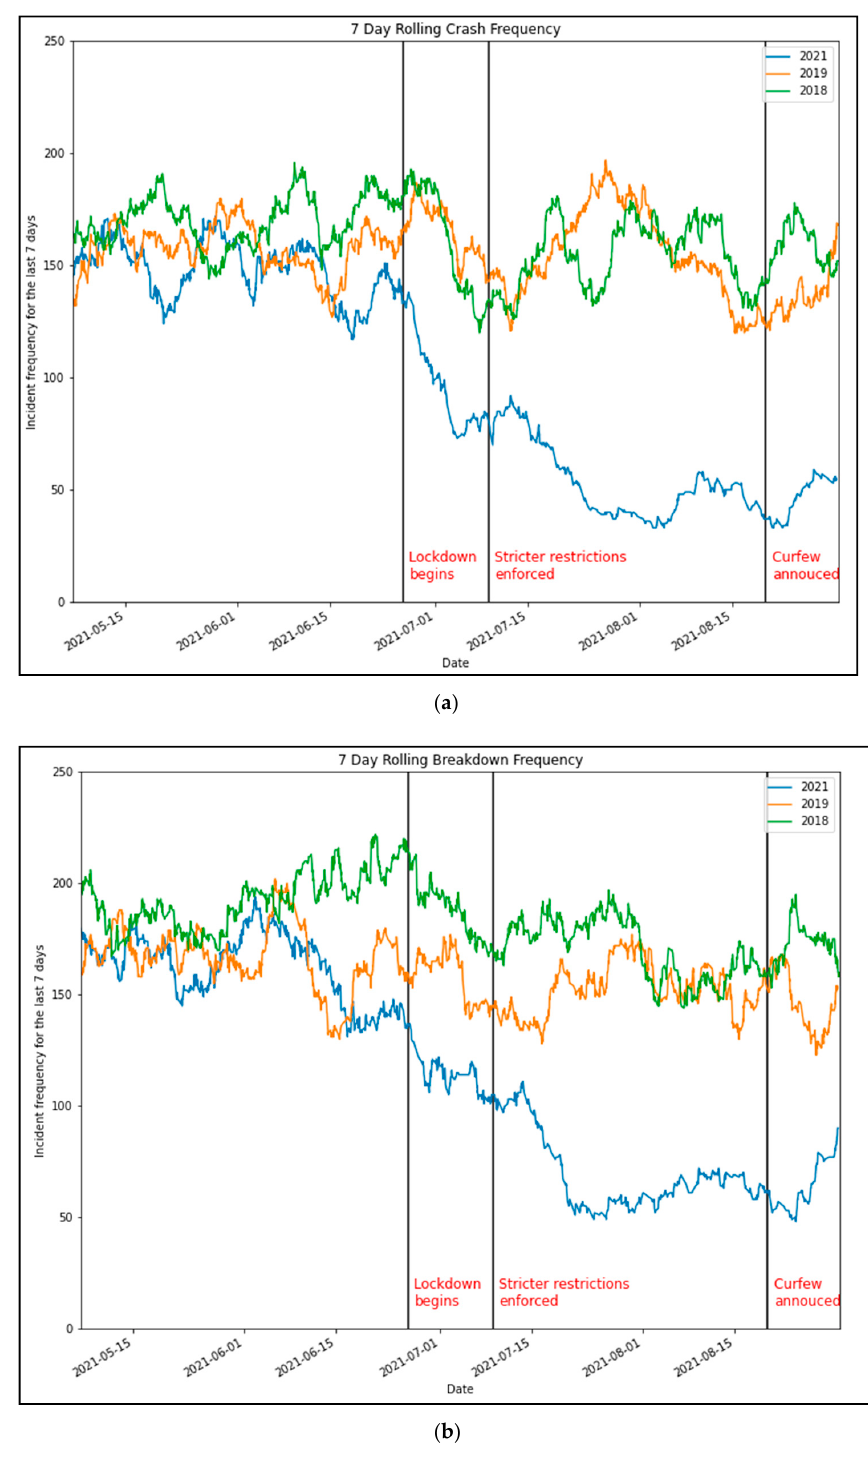
Figure 5. Comparison of seven-day rolling traffic incident frequency (2021 vs 2018 and 2019). ( a ) Crash frequency and ( b ) breakdown frequency. frequency and ( b ) breakdown